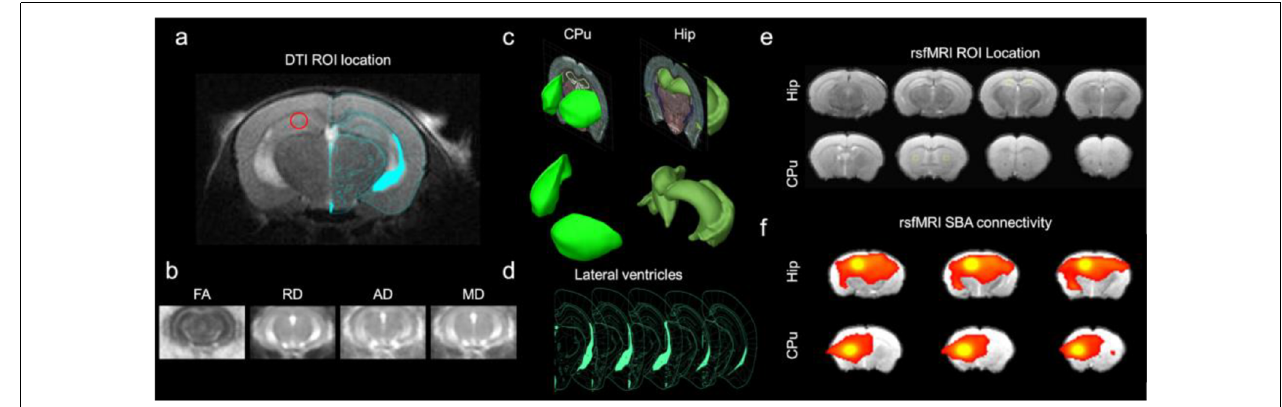
FIGURE 1 | Experimental design. (A) Diffusion tensor imaging (DTI) ROI location for hippocampal measurements overlaid on Franklin and Paxinos (2008) mouse brain atlas (Figure 52). (B) Resultant wild type control DTI measures to calculate VBS maps: fractional anisotropy (FA), mean diffusivity (MD), radial diffusivity (RD λ ⊥ ), axial diffusivity (AD λ //). (C) Three-dimensional rendering of ROI from the Allen brain atlas (Lau et al., 2008). (D) Lateral ventricle ROI for deriving ventricle volume. (E) The resting-state functional magnetic resonance imaging (rsfMRI) ROI location (yellow boxes outline the seeds) for seed-based analysis (SBA) for hippocampus (Hip) and caudate putamen (CPu). (F) Demonstrative resultant wild type control rsfMRI SBA functional connectivity (FC) maps for Hip and CPu seeds.